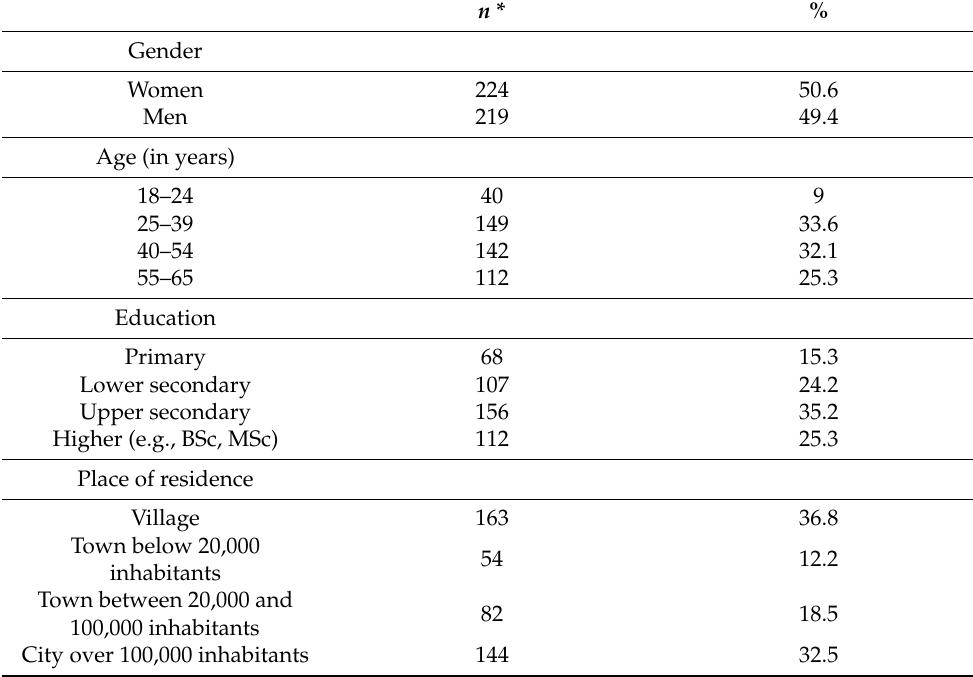
Table 1. Socio-demographic characteristics of the study sample. n *